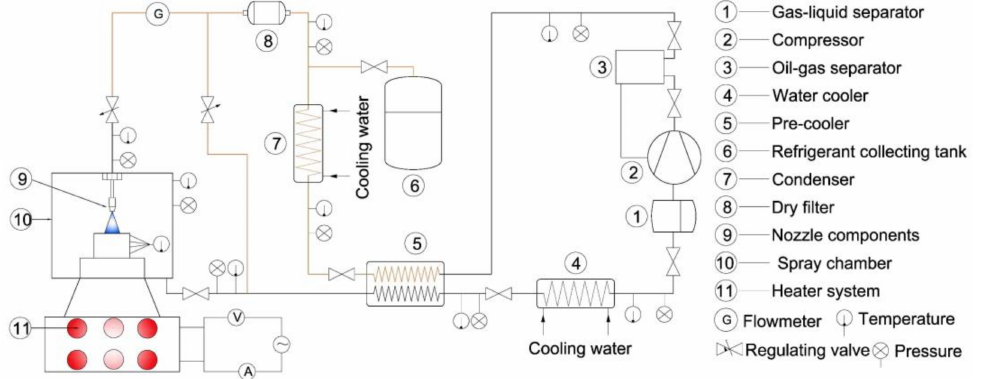
Figure 1. Experimental